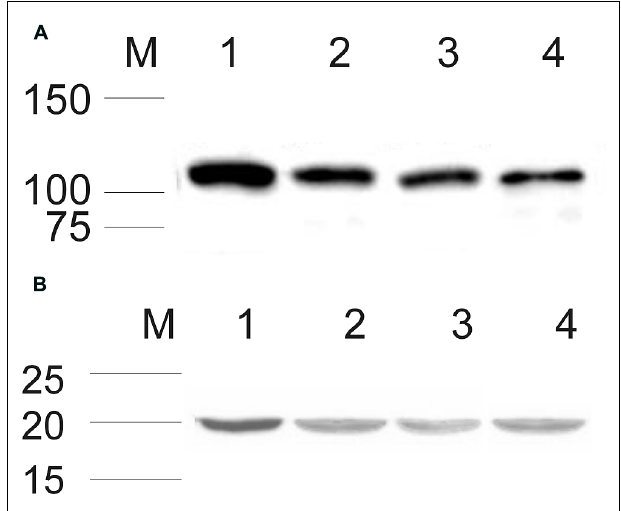
FIGURE 1 | Expression of ROS-GC1 and NC δ in the testes analyzed by Western blot. Membrane proteins from human, rat, and bovine testes were isolated and subjected toWestern blot analyses with specific antibodies against ROS-GC1 (A) , and NC δ (B) as described in “Materials and Methods.” Both types of analyzed proteins expressed in human, rat, and bovine testis are shown in lanes 2, 3, and 4, respectively.Western blotting of bovine retinal membranes was performed as a positive control and is shown in lane 1 in (A) and (B) .The positions of the molecular size markers are given